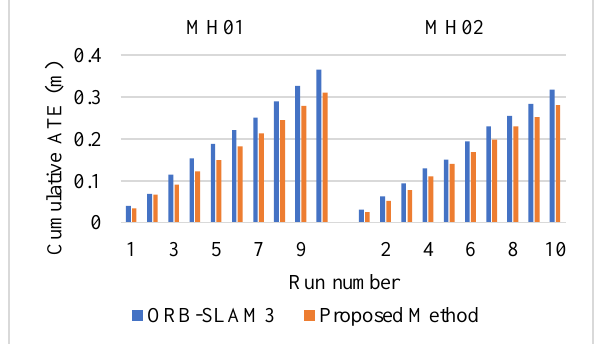
Figure 4. Cumulative ATE results in stereo-inertial mode .